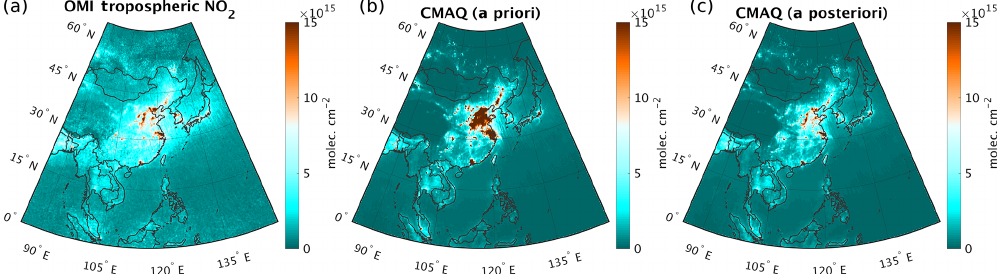
Figure 4. (a–c) Tropospheric NO 2 columns from OMI, WRF-CMAQ simulated with the prior emissions, and the same model but with the top-down emissions constrained by OMI / OMPS in May–June